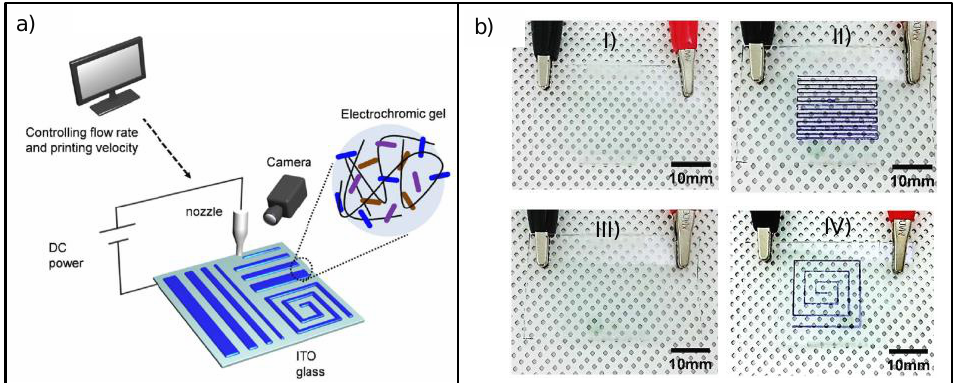
Figure 15. ( a ) Schematic illustration of electrostatic force–assisted dispensing printing and printed EC gel; ( b ) photographs of ECDs comprising EC gels printed by this technique with different shapes: ECDs in their ( I,III ) bleached state (left) and ( II,IV ) colored state upon applying a redox voltage of − 0.8 V (right). Adapted with permission from [90], copyright (2017) American Chemical Society.